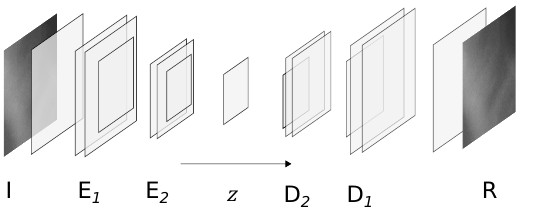
Figure 1. Overview of the AE model with encoder (E i ) and decoder (D i ) blocks. Adapted from [37] with permission from